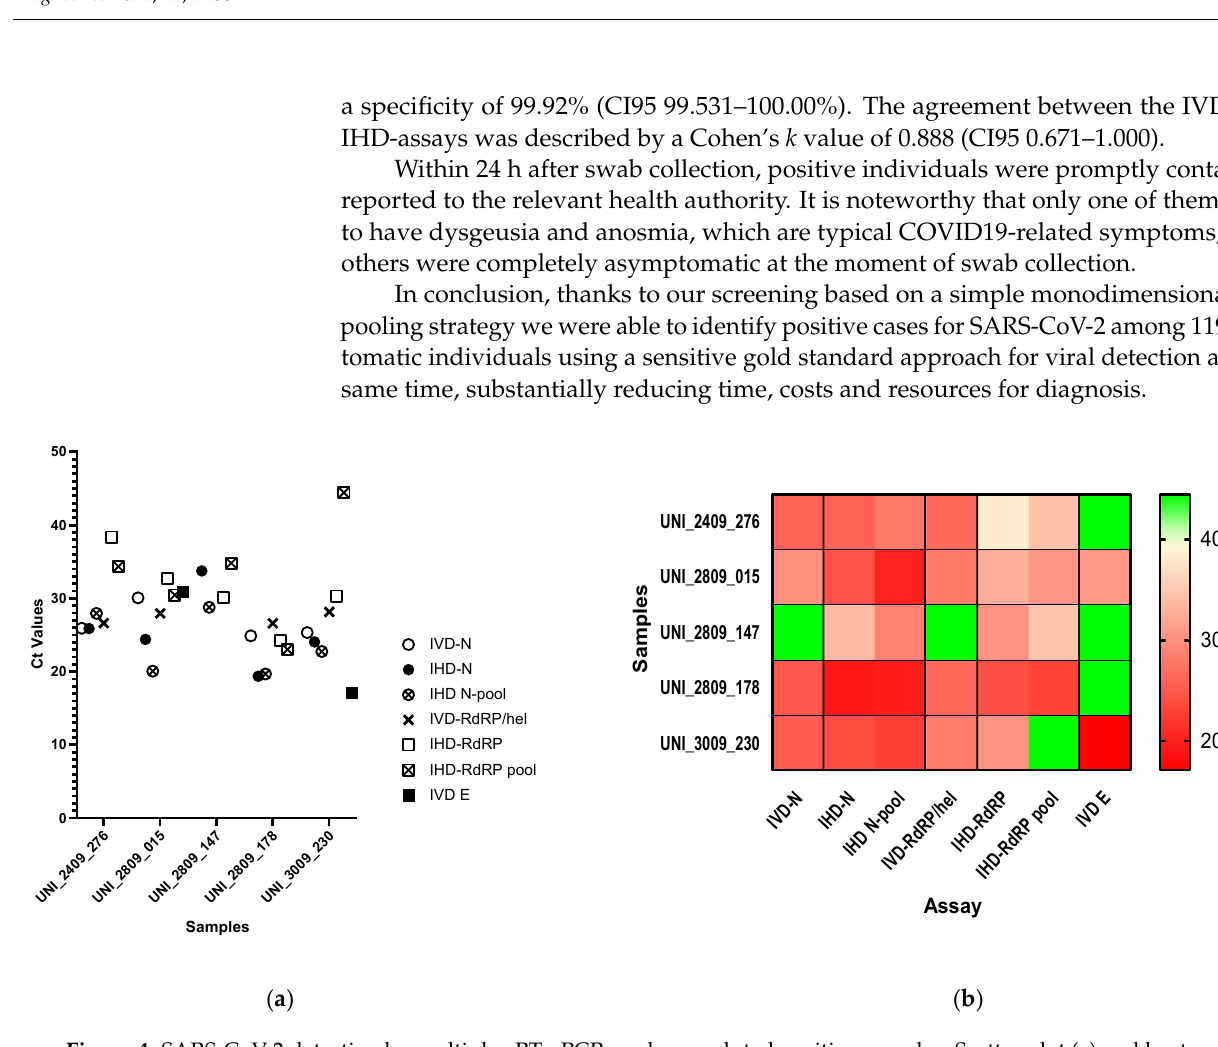
Figure 4. SARS-CoV-2 detection by multiplex RT-qPCR on deconvoluted positive samples. Scatter plot ( a ) and heat map ( b ) of Ct values recorded for each samples in distinct RT-qPCR assays.